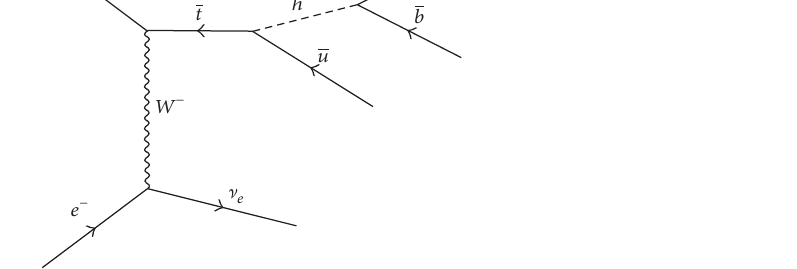
Figure1:Feynmandiagramforthepartonicprocess 𝑒 − 𝑏 → ] 𝑒 𝑡 → ] 𝑒 ℎ𝑞 → ] 𝑒 𝑏𝑏𝑞